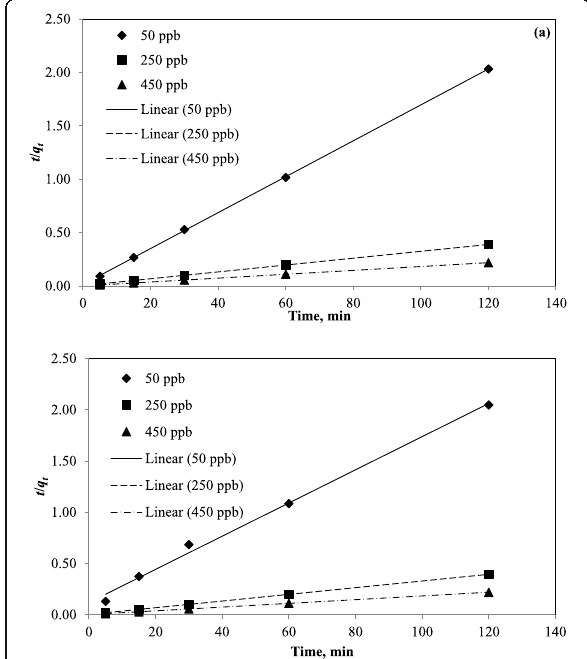
Fig. 8 Pseudo second order kinetic model for arsenate adsorption a GOFeZA and b